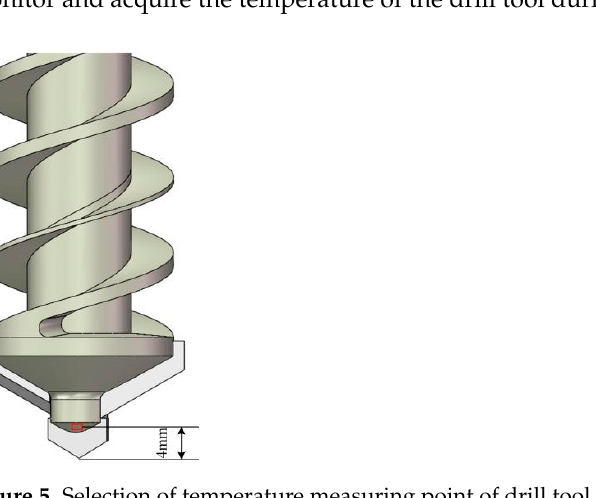
Figure 4. Experimental apparatus.